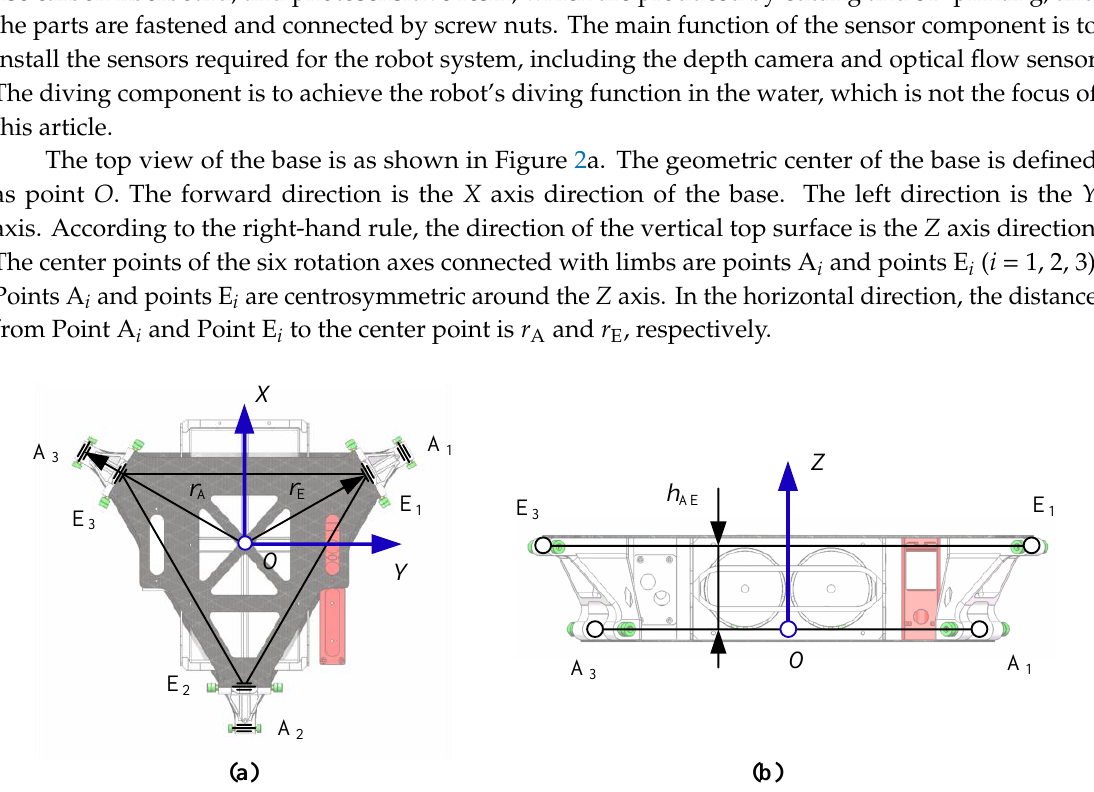
Figure 2. ( a ) Geometry structural and ( b ) dimensions of the base.